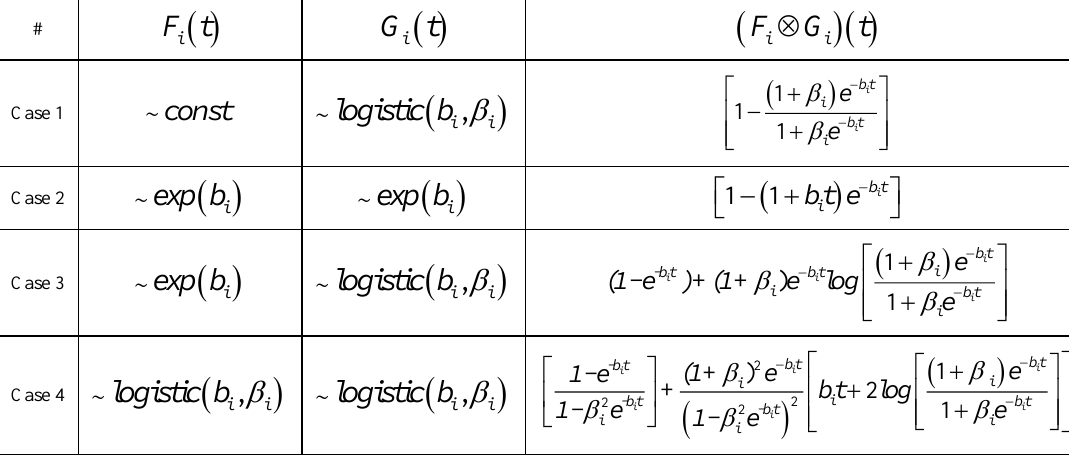
Table 1. Different forms for joint adoption function (Anand et al. (2014a))